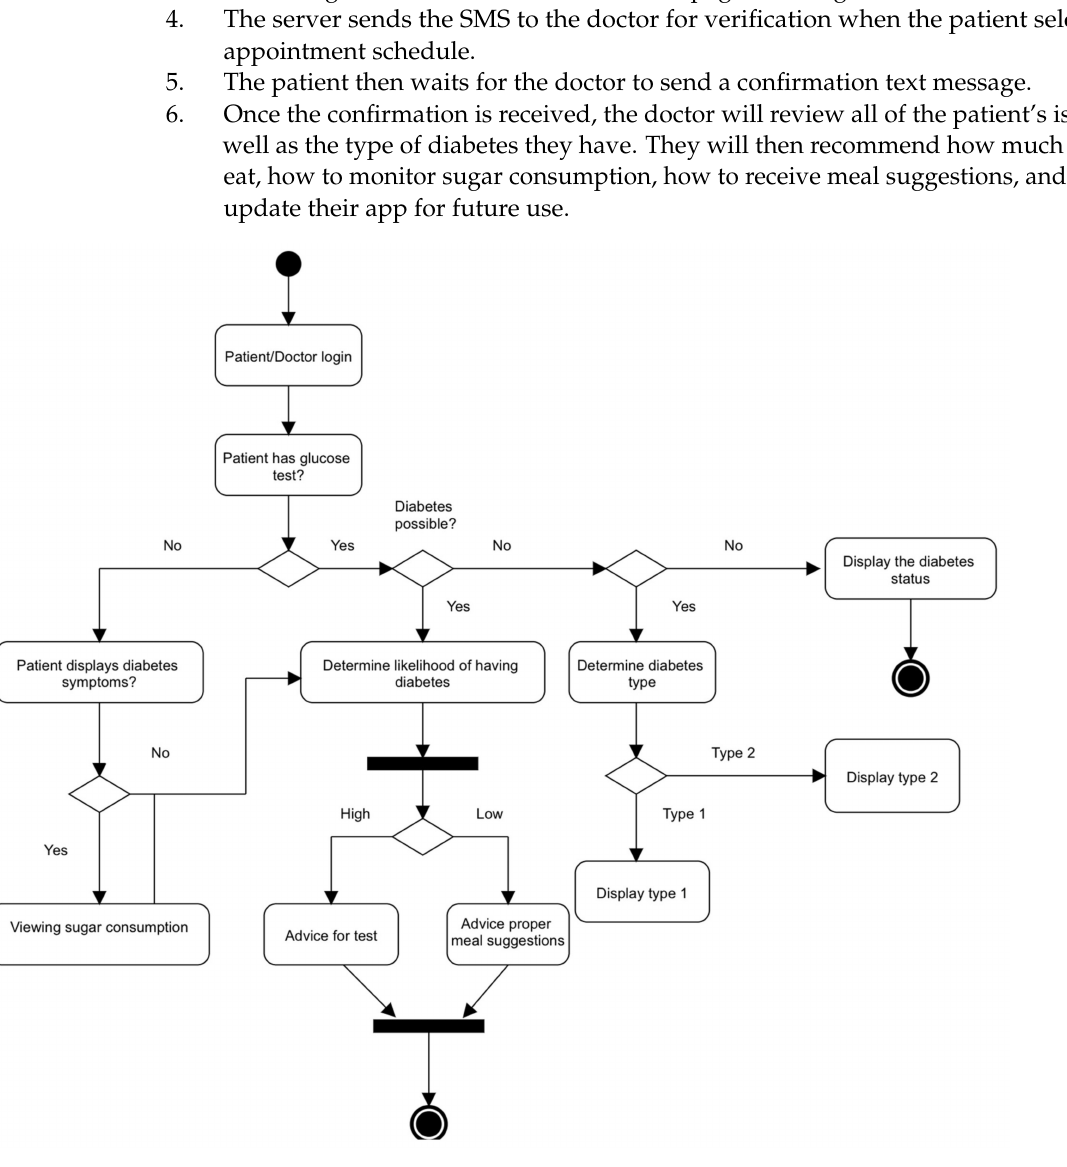
Figure 2. Activity diagram diabetes telehealth